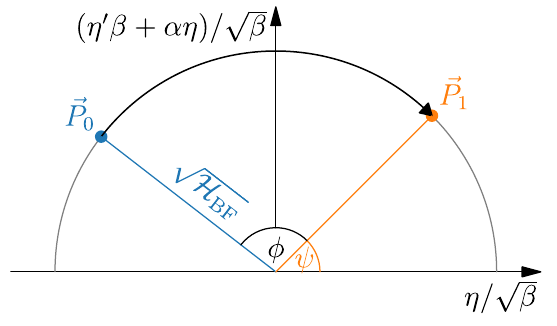
FIG. 12. Normalized phase space for dispersion in a two-bend cell with θ 0 > 0 , θ 1 < 0 (reverse-bend